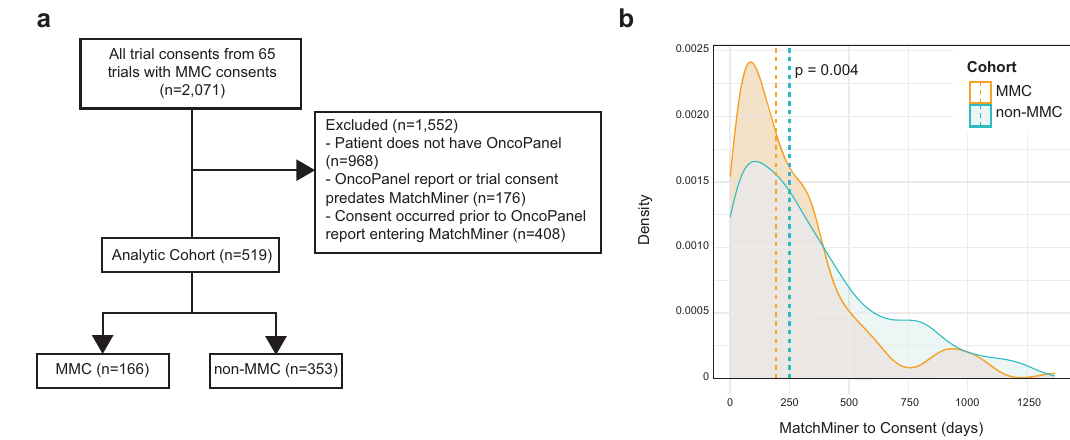
Fig. 4 MatchMiner decreases time to consent for precision medicine trials. a 2,071 consents from 65 trials in MatchMiner were fi ltered to generate comparison consents for MMC. 1,552 consents were excluded due to the patient not having an OncoPanel report or only having a failed OncoPanel report, the OncoPanel report or trial consent date were prior to the launch of MatchMiner, or the trial consent date preceded the ingestion of the OncoPanel report in MatchMiner. The remaining 519 enrollments were divided into MMC and non-MMC. b Density plot of time period from MatchMiner ingestion date to consent date. MMCs had a median of 195 days (IQR = 85, 341 days) compared to non-MMCs with a median of 250 days (IQR = 99, 491 days). Medians compared with a two-tailed Wilcoxon rank-sum